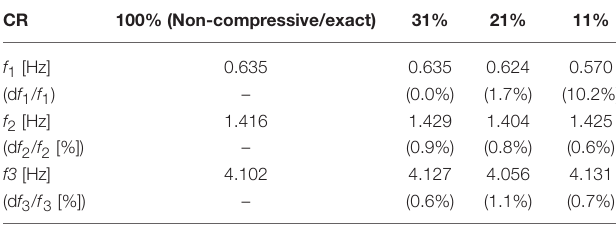
TABLE 2 | Frequency locations of peak PSD ordinates through peak-picking and percentage difference errors for the PSBS approach at various CRs and for Welch periodogram applied on the full-length signal (non-compressed)